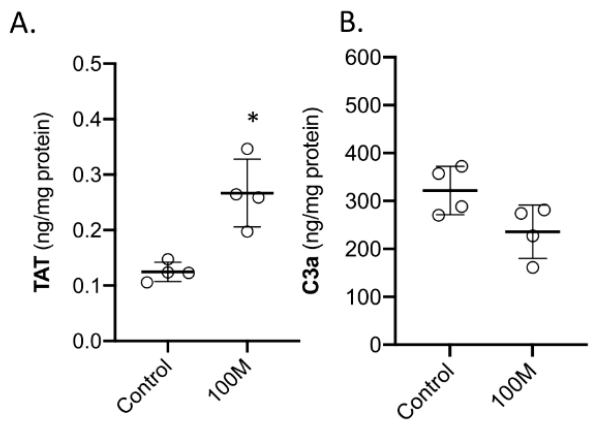
Figure 6. Assessment of coagulation and complement activation. ( A ) Thrombin–antithrombin complex (TAT) and ( B ) complement factor 3a (C3a) levels in kidney tissue that was collected ap- proximately two hours after intra-renal arterial administration of one hundred million MSCs (100M). Healthy kidney tissue was used from vehicle (PBS)-treated animals. Graphs present the individual values, mean, and standard deviation. * p < 0.05 vs. vehicle group.